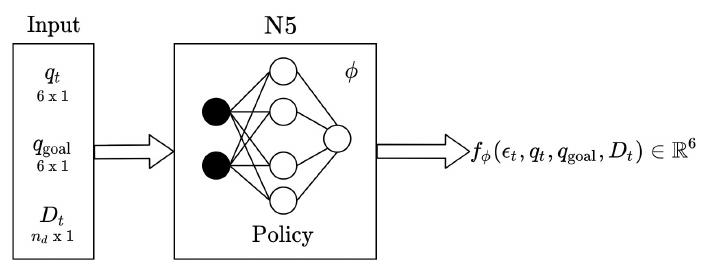
Figure 5. The deep neural network for the